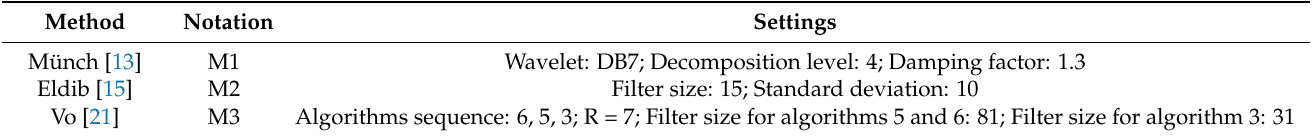
Table A5. List of the other methods and used settings (notations of the parameters are adopted from the original